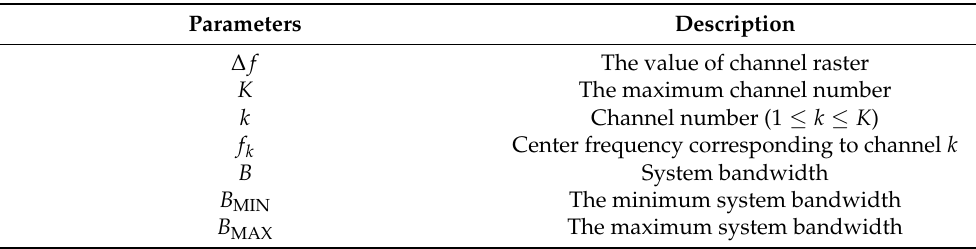
Table 1. The description of parameters necessary to explain a frequency